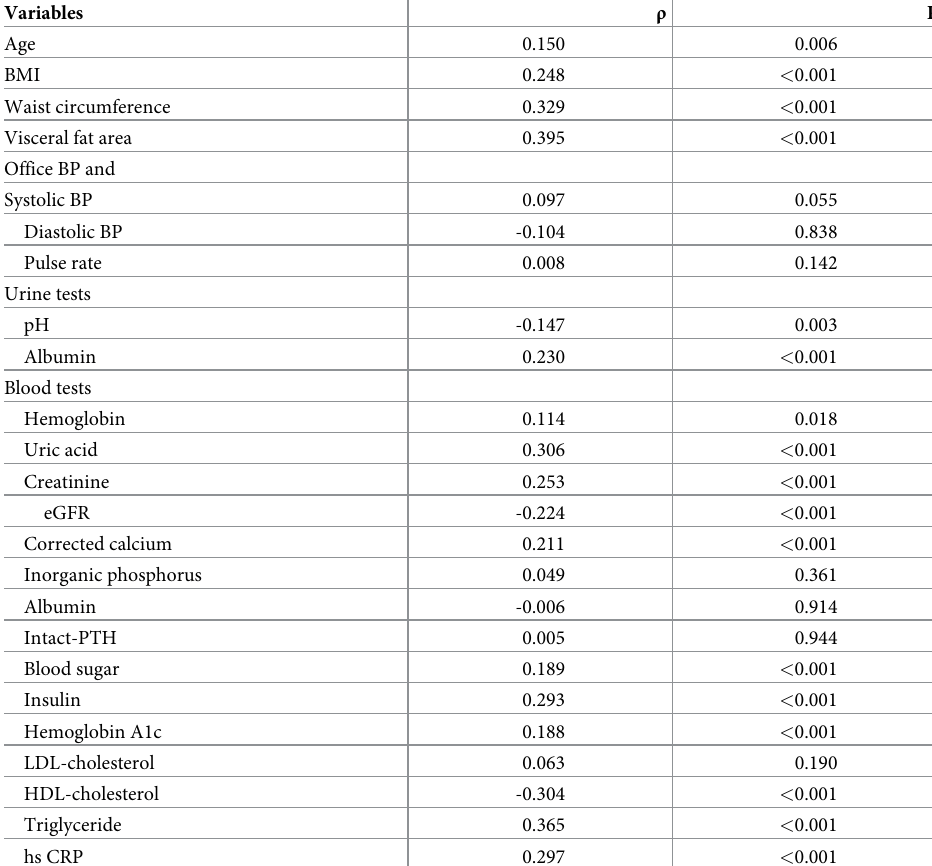
Table 4. Single correlation analyses with serum soluble (pro)renin receptor